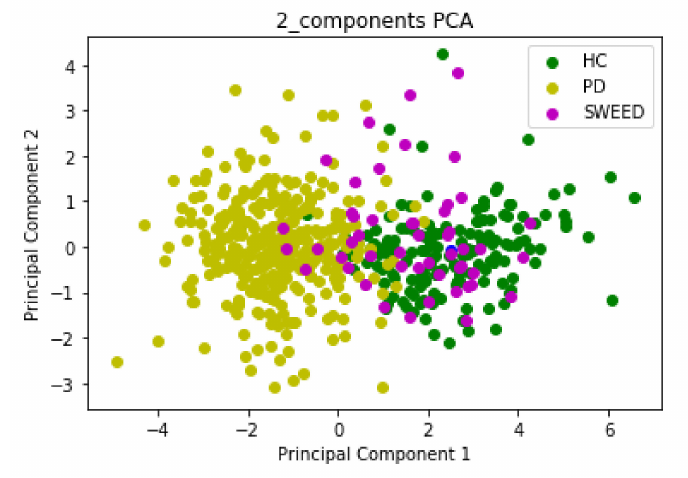
Figure 3. The new feature subspace constructed using PCA with class labels.